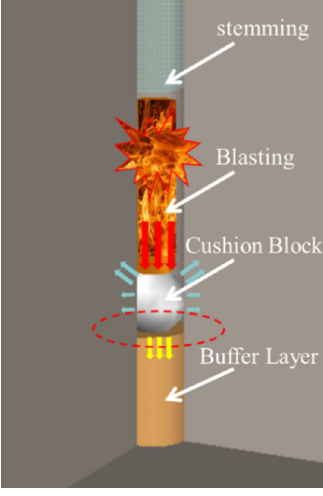
Figure 1. Energy-relieving structure.